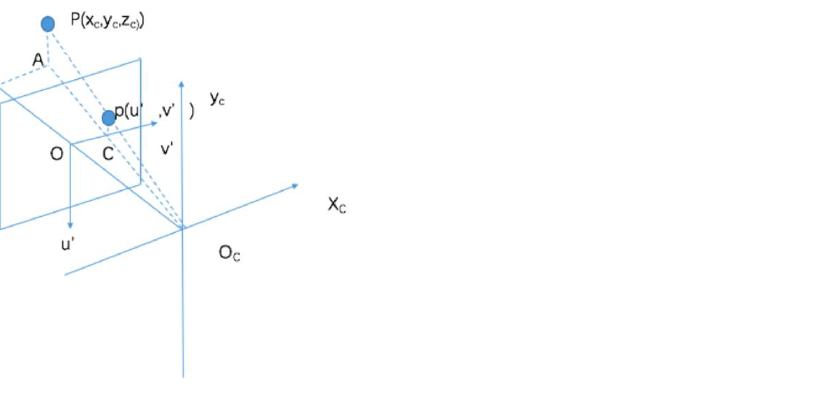
Figure 6. The relationship between the camera coordinate system and the image-plane coordinate system.